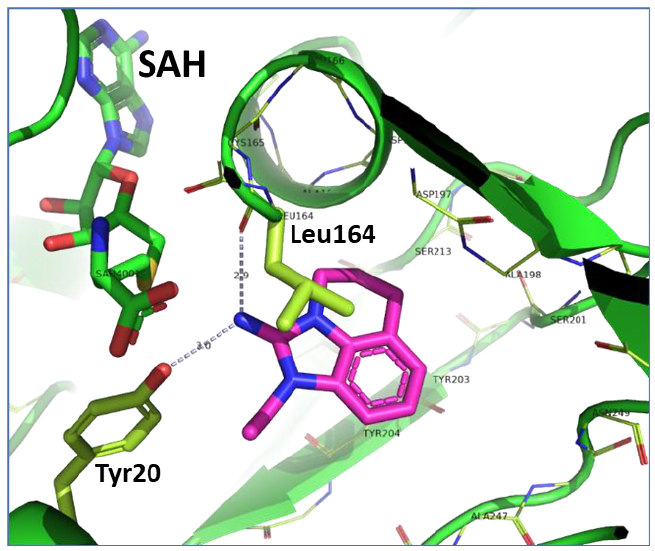
Figure 5. Crystal structure showing the interactions of ( 3 ) with hNNMT.